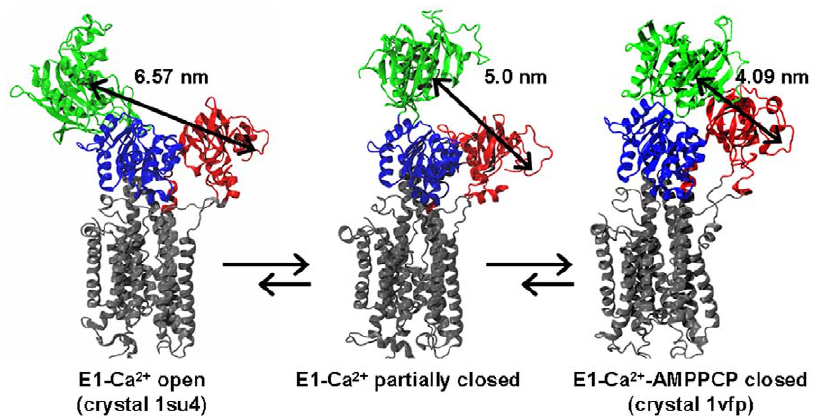
Figure 1. Proposed model of SERCA conformational dynamics induced by calcium. The model is based on FRET experiments (Winters et al. [16]) showing that, in the presence of calcium, the SERCA headpiece samples a broad spectrum of conformations ranging from an open (E1-Ca 2 + open, PDB:1su4) to a fully closed one (E1-Ca 2 + -AMPPCP closed, PDB:1vfp). SERCA is colored according to its four functional domains: N domain (green), P domain (blue), A domain (red) and TM domain (grey). We highlight the C a -C a distance between residues Met1 (A domain) and Lys515 (N domain), which were used as labeling sites to evaluate N-A interdomain distances.